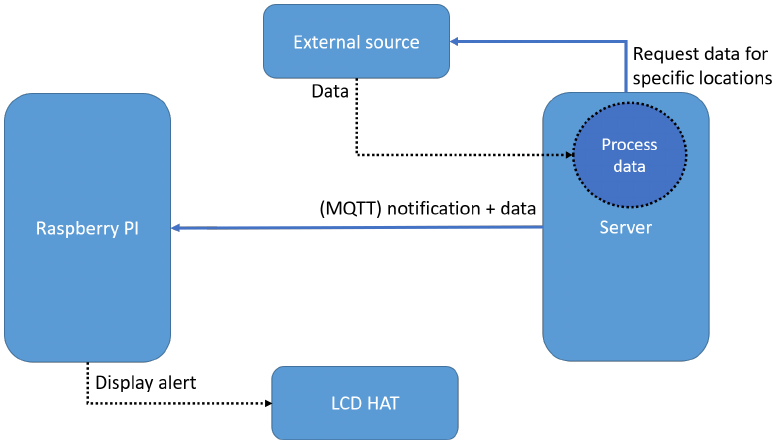
Figure 5. The message flow for alerts.